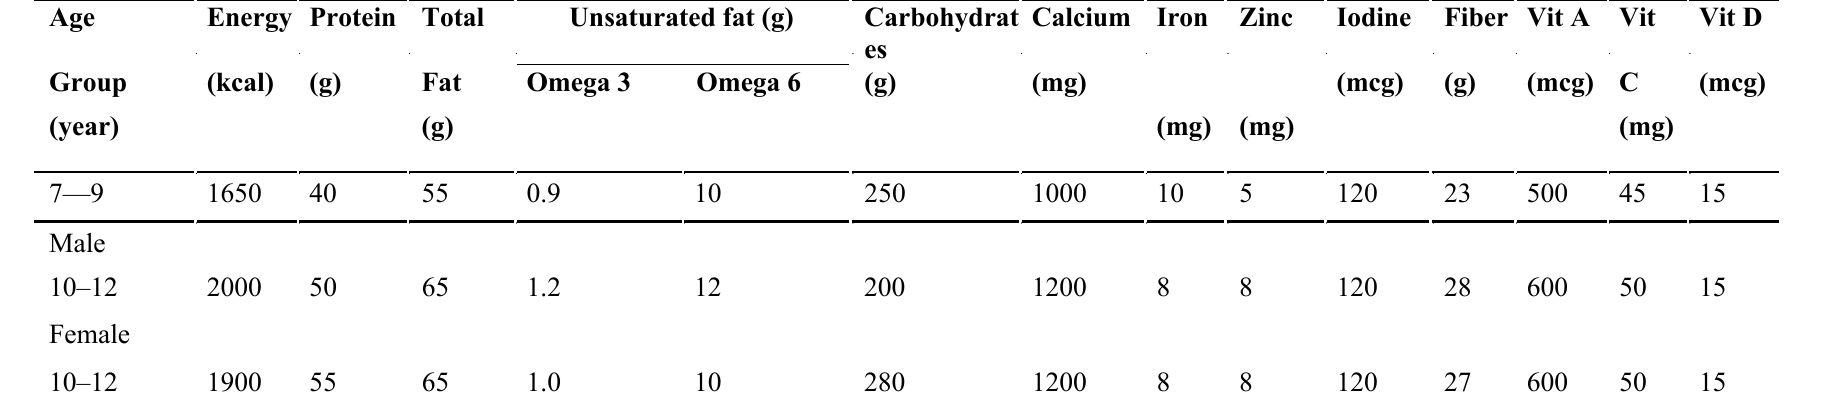
Table 1 . Recommended dietary intakes for school-age children Age